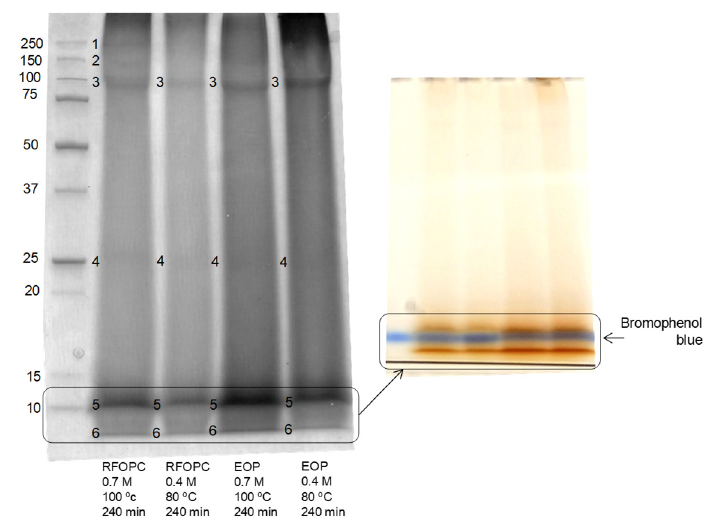
Figure 6. SDS ‐ PAGE profiles of protein products obtained from the residual fraction from olive pit cleaning (RFOPC) (lanes 2 and 3) and extracted olive pomace (EOP) (lanes 4 and 5) by alkaline conditions after phenolic extraction. The protein markers kit was at lane 1.